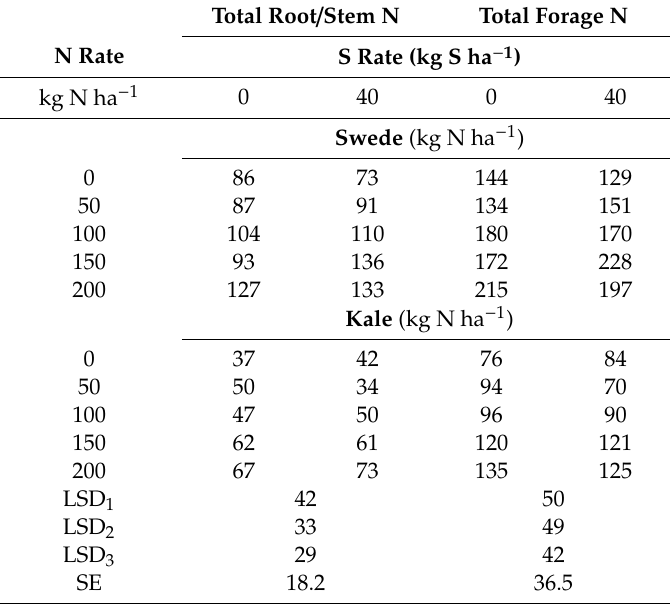
Table 6. Swede and kale total root / stem nitrogen (N) accumulation and total N accumulated in forage (leaf + root / stem) with five N rates and two sulfur (S) rates averaged across three environments at Prosper and Walcott, ND, USA, in 2012 and 2014. Total Root / Stem N Total Forage N N Rate S Rate (kg S ha − 1 ) kg N ha −